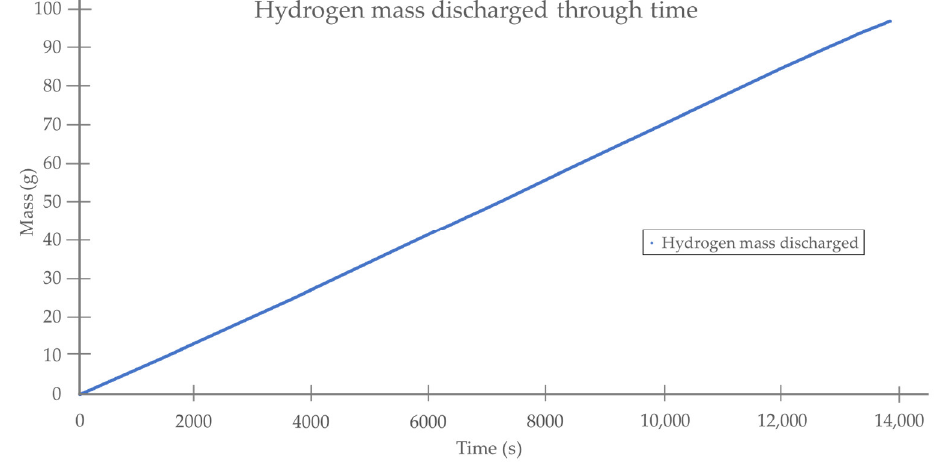
Figure 12. Hydrogen mass discharged through time.